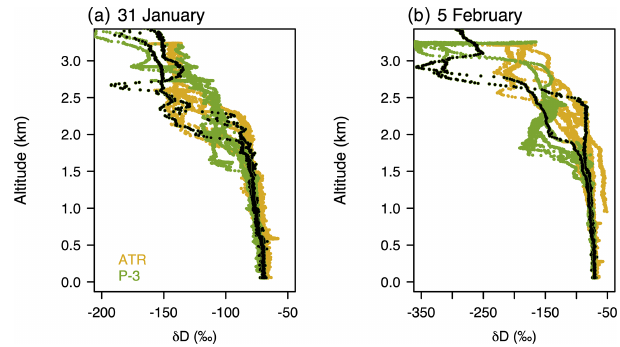
Figure 13. Vertical δ D profiles from the ATR (yellow) and the P-3 (green) for (a) 31 January (DOY 31) and (b) 5 February (DOY 36), the 2days on which both aircraft were in the air simultaneously. P- 3 observations with black centers represent takeoffs and landings, which were flown in closest proximity to the ATR and show the greatest structural similarity to ATR δ D